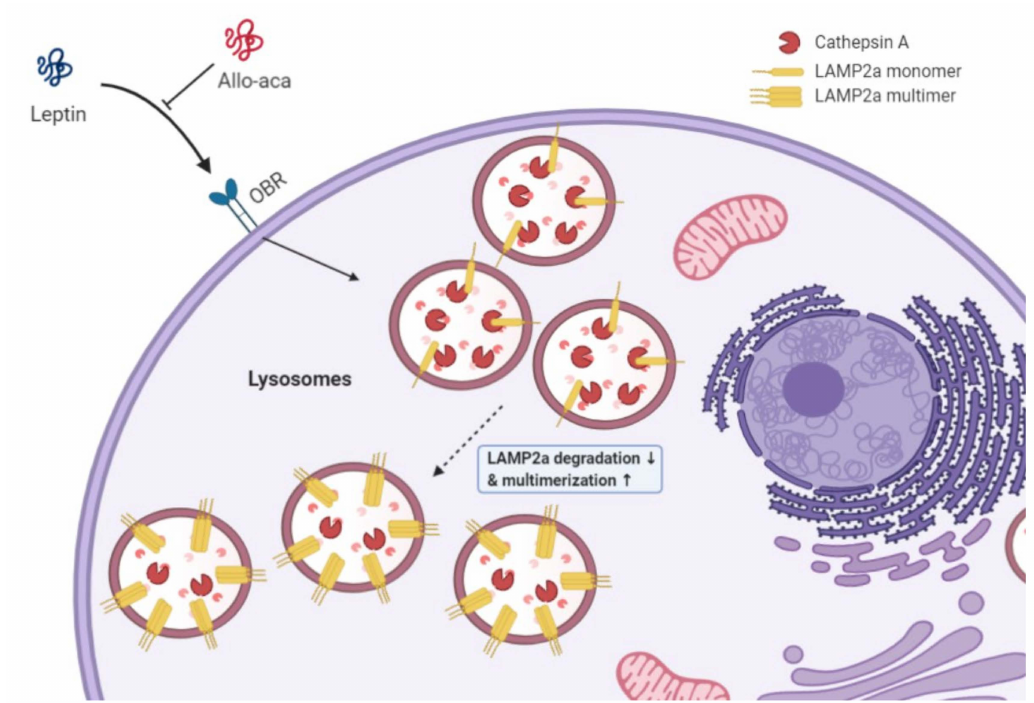
Figure 5. Schematic images describing the summarized results in this study. Leptin downregulated CTSA and, following delayed LAMP2a degradation, resulted in CMA activation and stimulation of LAMP2a multimerization through the mTORC2 / PHLPP1 / AKT 1